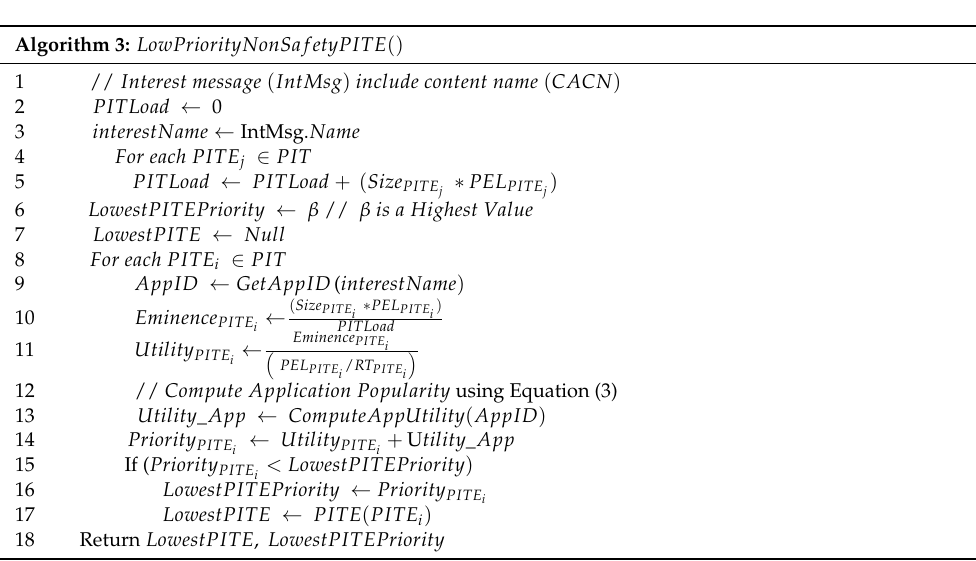
Algorithm 3: LowPriorityNonSafetyPITE